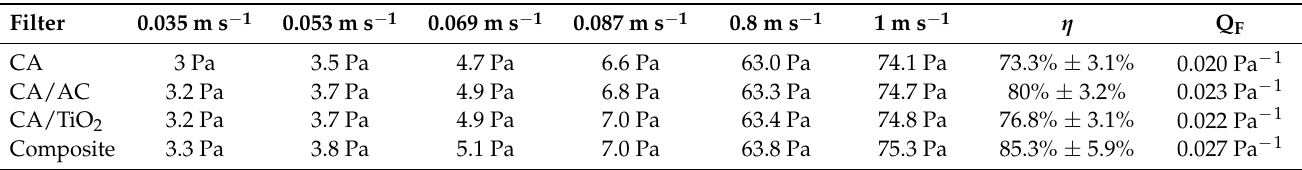
Table 3. Pressure drop results for the different filters at different face velocities. Filtration efficiency to particle size between 0.3 and 0.5 µ m and related quality factor calculated with pressure drop at 0.8 m s − 1 face velocity. Filter 0.035 m s −